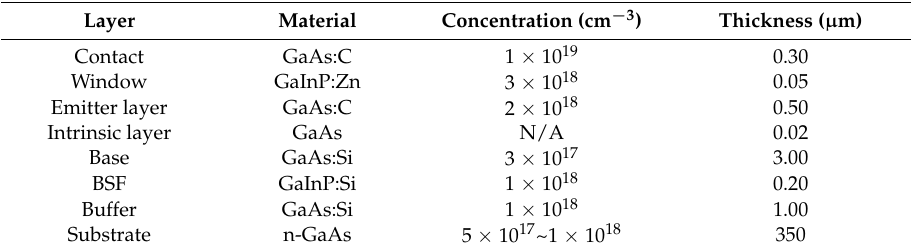
Table 1. Epitaxy information of the GaAs solar cell